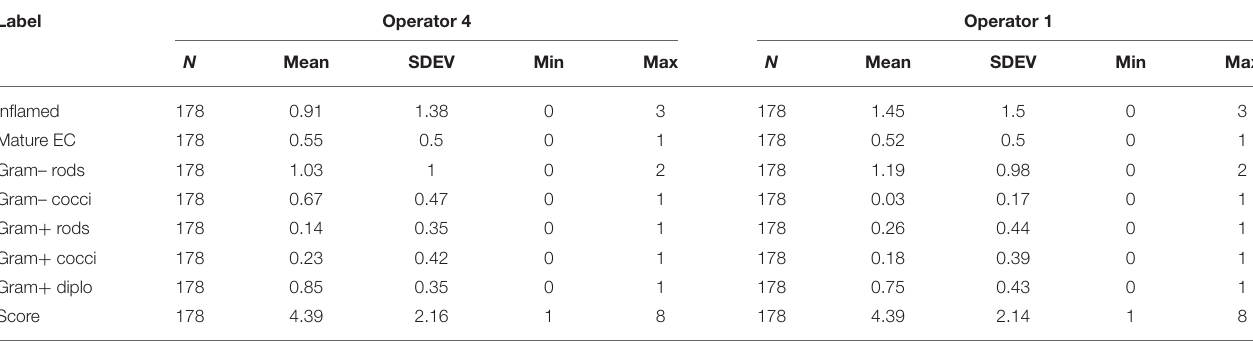
TABLE 5 | Scoring concordance between the two operators (Subsample D). Label Operator